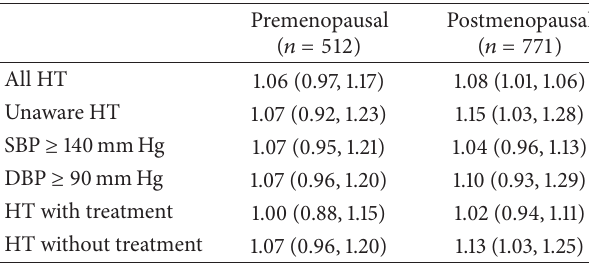
Table 7: Adjusted odds ratio (AOR) for high blood pressure associated with log (BPA) in premenopausal and postmenopausal women. Premenopausal ( 𝑛 = 512 )